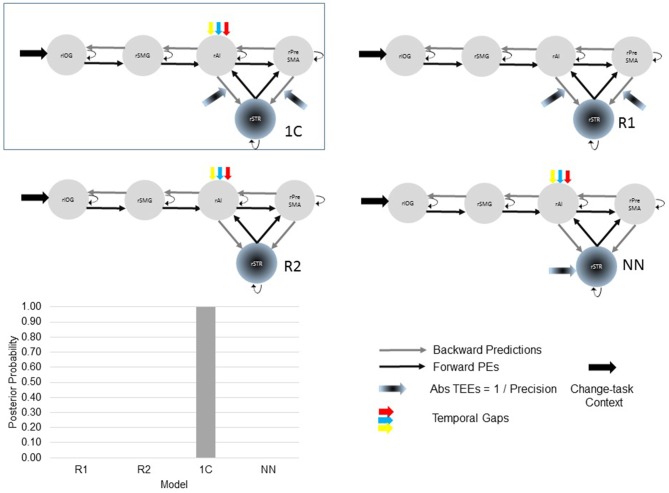
The optimal (winning) model and three competing models testing our hypotheses. Two of the alternative (reduced) models (R1 and R2) were constructed by removing, from the winning (full) model, driving and modulatory inputs defined in our hypotheses. The other, non-nested (NN), model was defined upon previous works. Bayesian model selection provided support to the winning model 1C (PP > 0.99). The PPs of the three alternative models are close to 0.